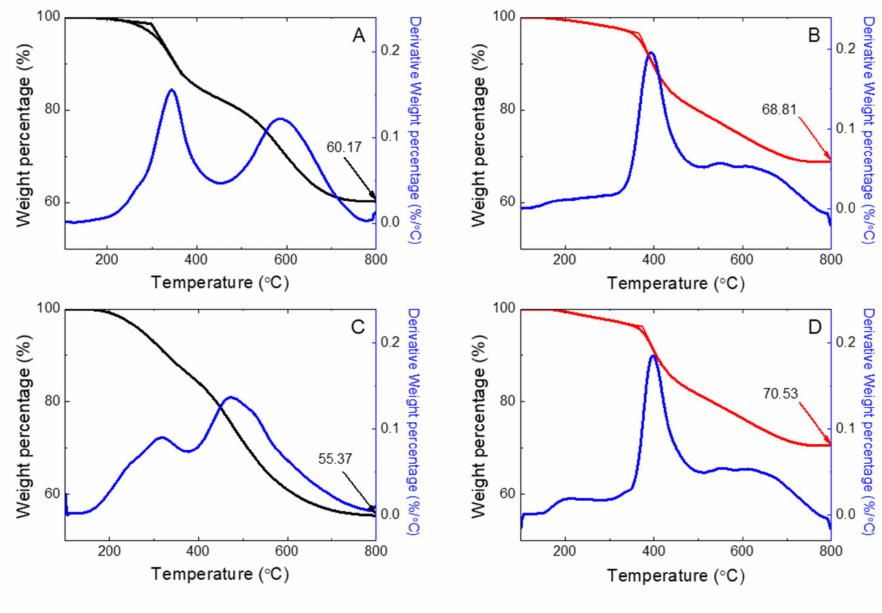
Figure 11. Thermal decomposition of mesoporous organosilica samples under flowing air gas from 100 ◦ C to 800 ◦ C: PMOA-2 (A), PMOB-1 (B), PMOAH-2 (C), PMOBH-1